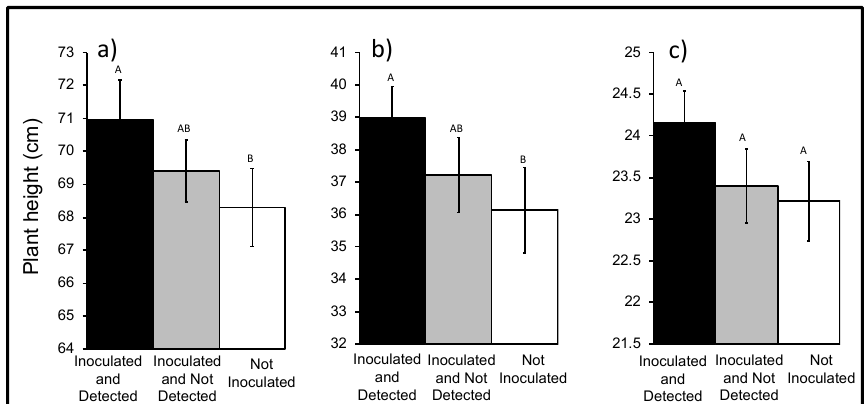
Figure 3. Height of ‘Inoculated and Detected’ or ‘Inoculated and Not Detected’ and ‘Not Inoculated’ ( a ) AWP ( n = 111), ( b ) cereal rye ( n = 142), and ( c ) canola ( n = 99). Error bars represent ± standard error of the mean. The bars sharing common letters are not significantly different at p = 0.05.